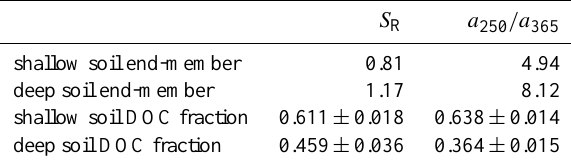
Table 4. Estimates of soil DOC sources calculated using LoadEst (Runkel et al., 2004). Uncertainties represent 1 s.d. of the average for the 3 years of the record (2011–2013). Shallow and deep soil DOC fractions indicate the fraction of the total DOC load estimated to derive from shallow and deep soil DOC pools, respectively. Cal- culations were made based on shallow and deep soil DOM end- members defined by observed maximum and minimum S R and a 250 /a 365 values. S R shallow soil end-member deep soil end-member shallow soil DOC